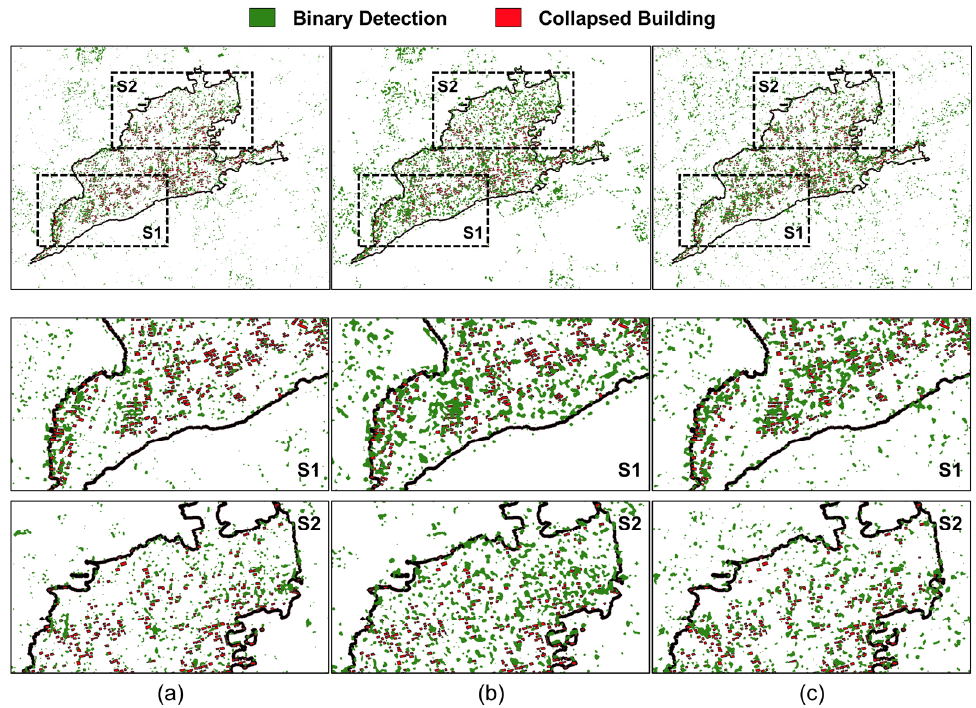
Figure 6. The damage detection map (green) derived from ( a ) intensity difference method, ( b ) GLCM-PCA method, and ( c ) proposed LTCHD method (Top: study area Mashiki town, Middle: S1 zoom areas, Bottom: S2 zoom areas). Red polygons denote reference building damages.